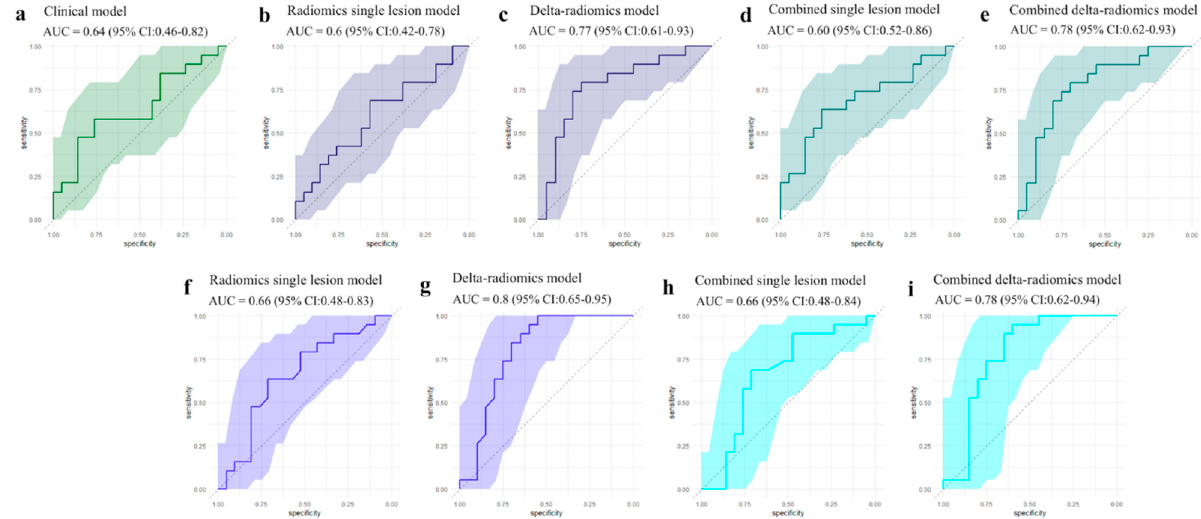
Figure 3. The ROC curves for treatment response prediction of the generalized linear ( a , b , c,d , e ) and the random forest ( f , g , h , i ) models obtained on the external dataset.